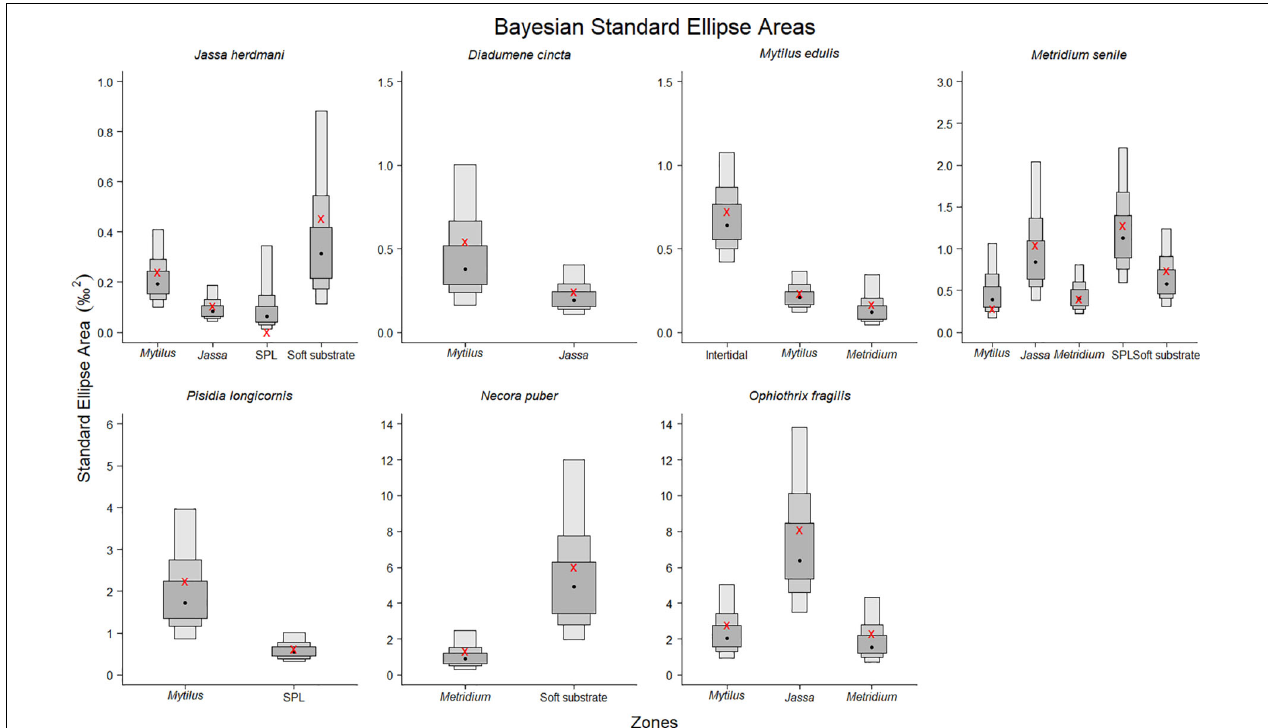
FIGURE 5 | The posterior Bayesian estimates of the standard ellipse area (SEA B ) for the seven studied species in the different zones. Shaded density plots represent 50, 75, and 95% credible intervals. SEA B mode is represented by a black circle and SEA C by a red mark. The scale of the y-axis differs per species; smallest scale on the top left and largest scale on the bottom right. SPL is the scour protection